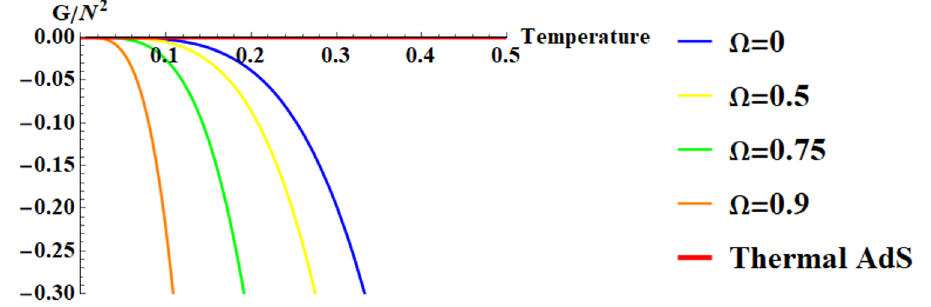
Figure 4 . The free energy G as function of temperature T for Φ = Φ ∗ = 3 . The angular velocity Ω = Ω = 0 , 0 . 5 , 0 . 75 , 0 . 95 from right to left. The curves approach the origin G = T = 0 without a b reaching it . The special case Ω a = Ω b = 1 is not a curve, it is the single point G = T = 0 .